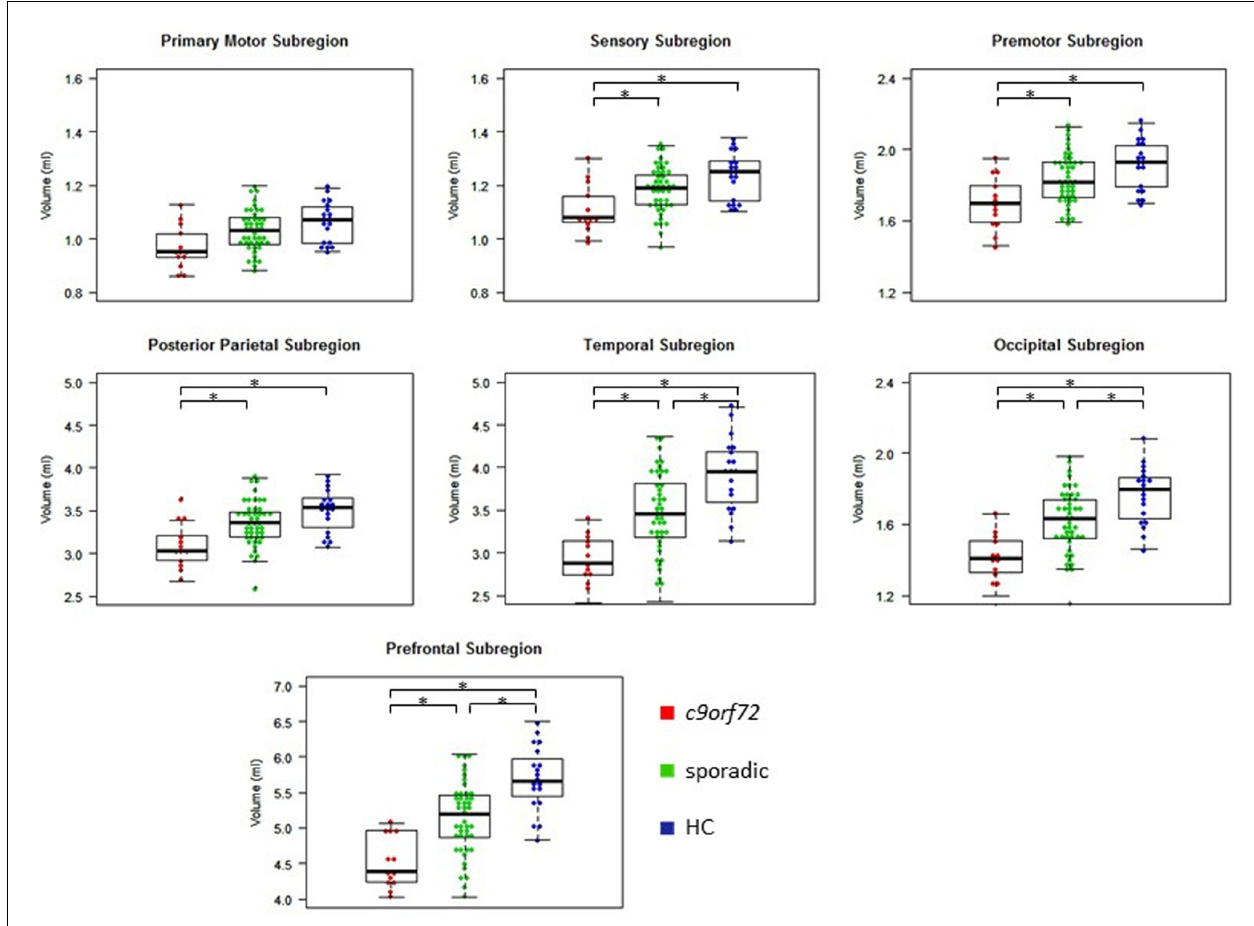
FIGURE 2 | Volumes of thalamic subregions. ∗ Indicates significant differences.